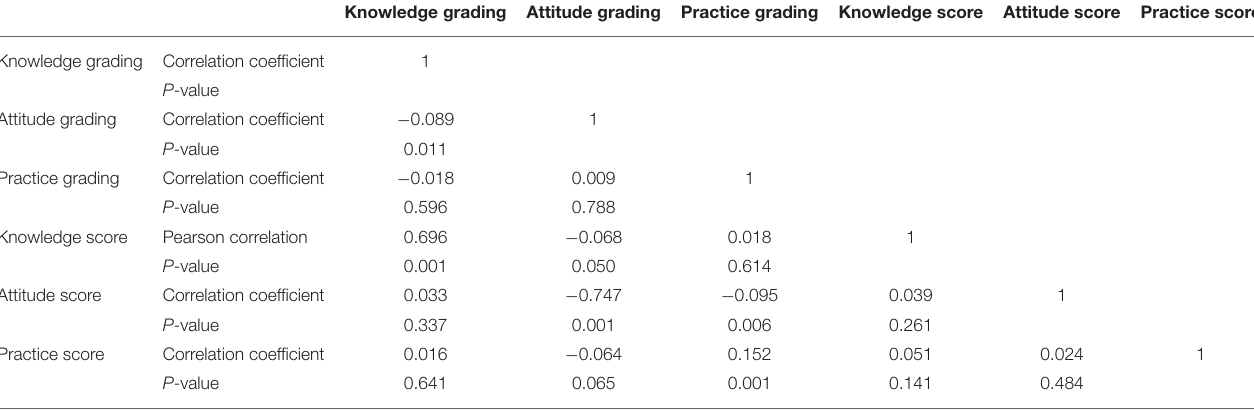
TABLE 6 | Spearman correlations between knowledge, attitude, and practices toward